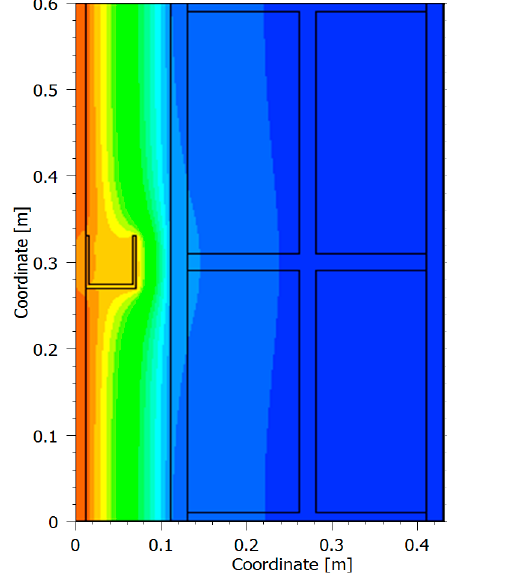
Figure 16. Temperature profile of the simulated wall during the coldest hour for 10 cm and 6 cm insulation scenarios.